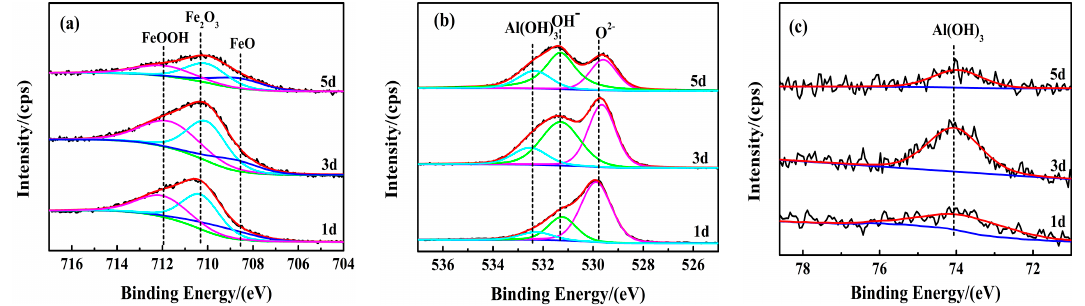
Figure 4. XPS spectra of 12Cr1MoV steel corroded in the TCSA solution for 1, 3, and 5 d: ( a ) Fe2p, ( b ) O1s, and ( c ) Al2p.